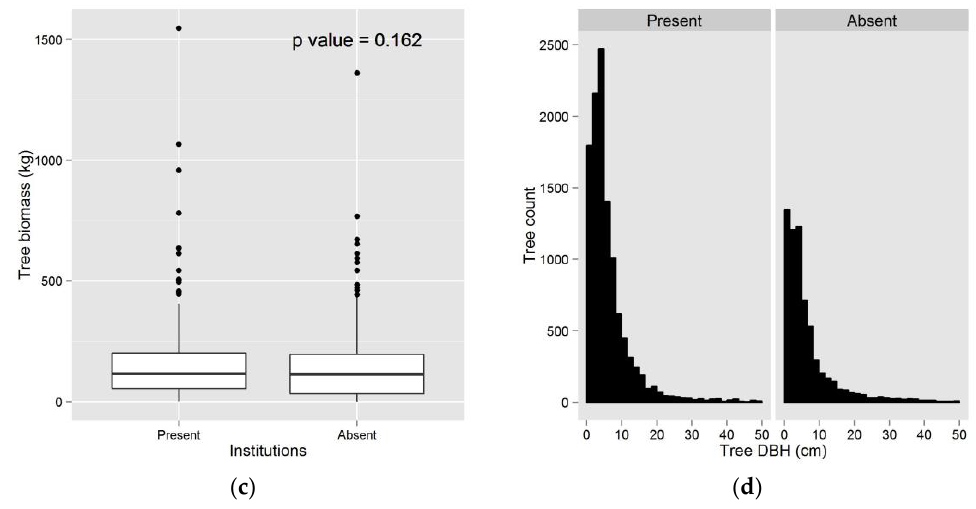
Figure 4. ( a ) tree density (no. of trees/ha); ( b ) tree species richness; ( c ) tree biomass; and ( d ) frequency of tree DBH in the forest patch of villages present and absent local forest institutions.